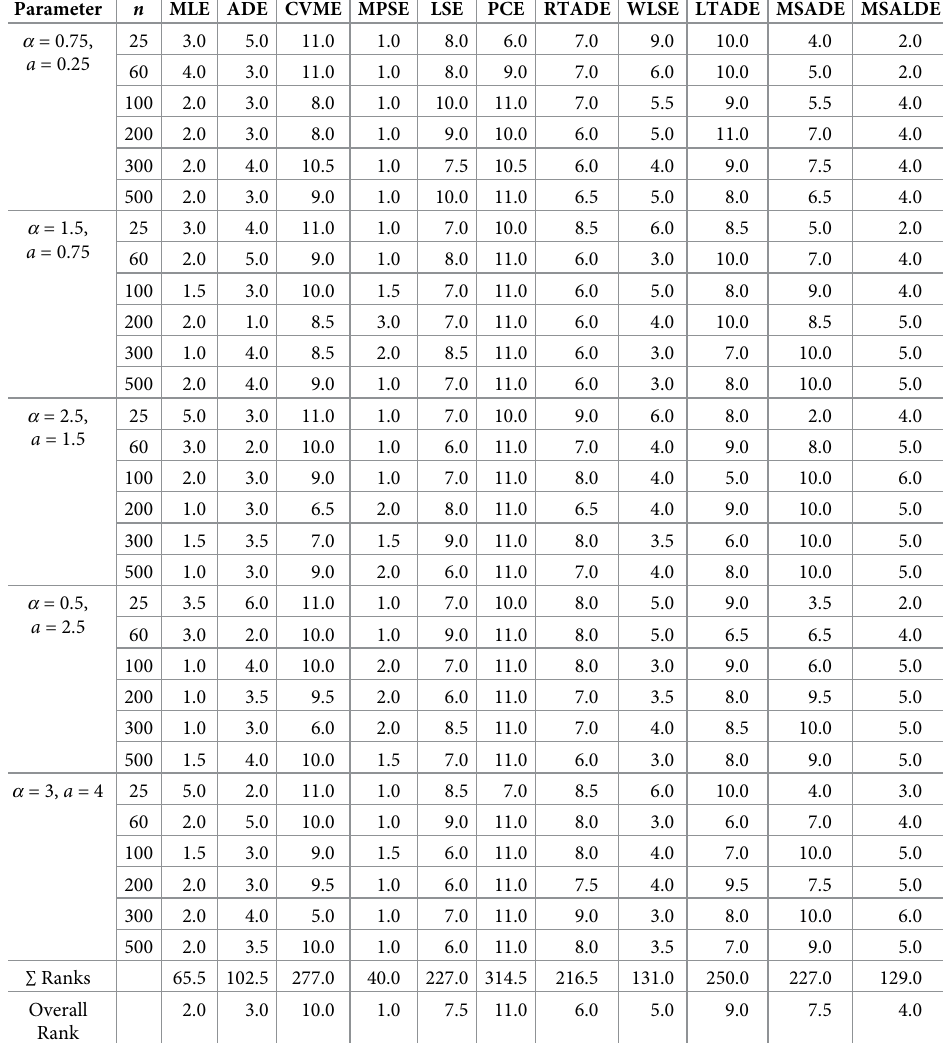
Table 6. Partial and overall ranks of all the methods of estimation of WBHD by various values of model parameters.